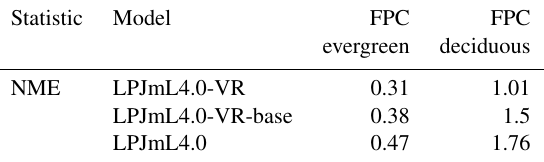
Figure B9. Mean sum (2001–2010) of below-ground biomass (BGB; sum of tree coarse and fine roots) of evergreen and decid- uous tree PFTs simulated with LPJmL4.0-VR under CRU climate forcing.